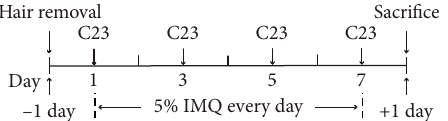
Figure 1: Experimental schedule of the use of IMQ and C23 in